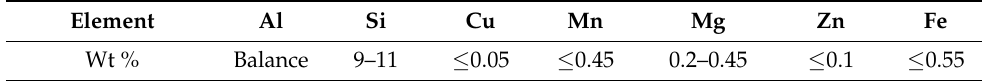
Table 1. AlSi10Mg nominal chemical